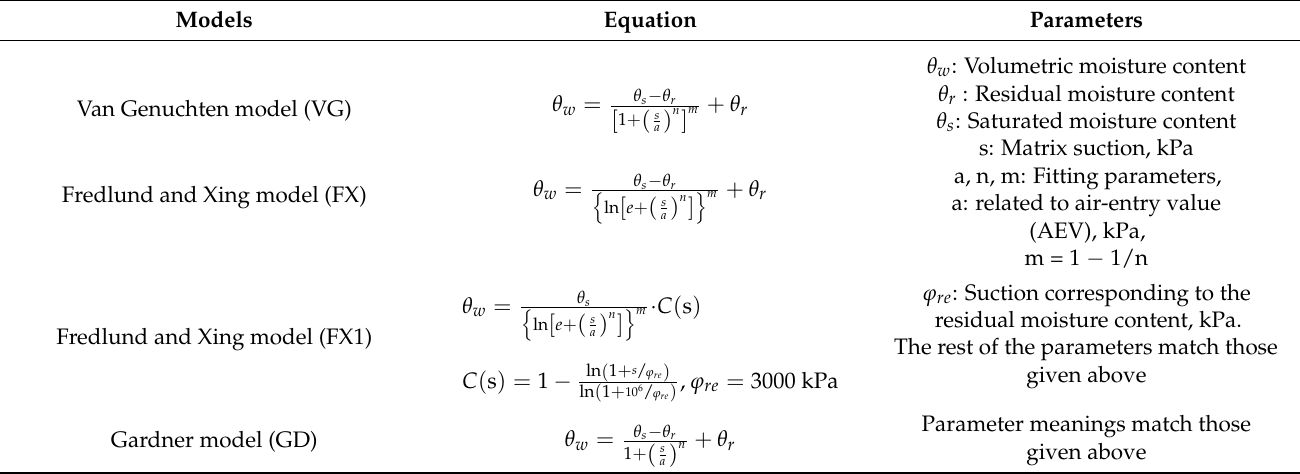
Table 4. Soil–water characteristic curve models